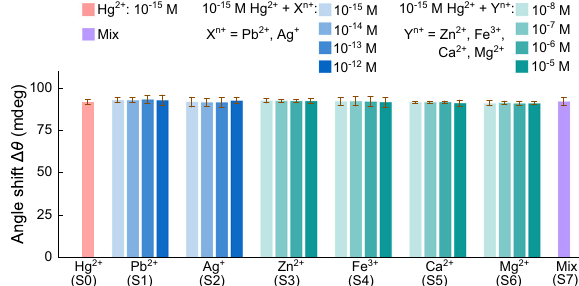
Fig. 4 Interference study of Hg 2 + detection. GB-based SPR sensor response ( Δ θ ) to Hg 2 + at a fi xed concentration (10 − 15 M) with increasing concentration of interfering ions (Pb 2 + , Ag + , Zn 2 + , Fe 3 + , Ca 2 + , and Mg 2 + ). S0 is the 10 − 15 M Hg 2 + solution as reference. S1(S2) are the solutions of 10 − 15 M Hg 2 + and Pb 2 + (Ag + ), the Pb 2 + (Ag + ) concentration is varied from 10 − 15 M to 10 − 12 M. S3 – S6 are the solutions of 10 − 15 M Hg 2 + and one of the naturally abundant interfering Zn 2 + , Fe 3 + , Ca 2 + , and Mg 2 + ions, the Zn 2 + , Fe 3 + , Ca 2 + , Mg 2 + concentration is varied from 10 − 8 M to 10 − 5 M. S7 is the solution of 10 − 15 M Hg 2 + ions and mixed interfering ions of Pb 2 + , Ag + at 10 − 12 M and Zn 2 + , Fe 3 + , Ca 2 + , Mg 2 + at 10 − 5 M. All error bars is the standard deviation of SPR angle shift from fi ve repeated